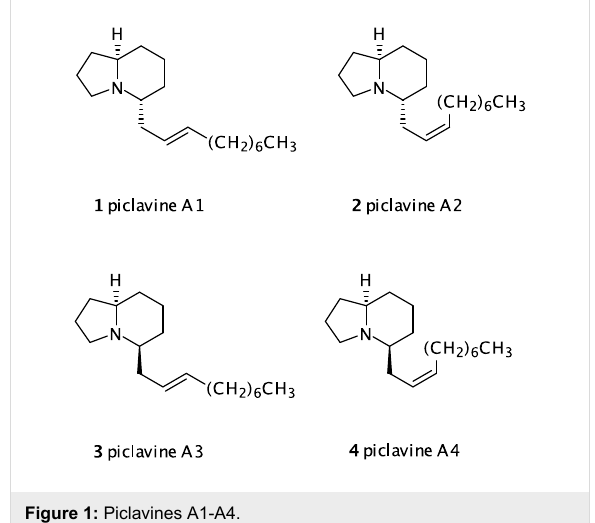
Figure 1: Piclavines